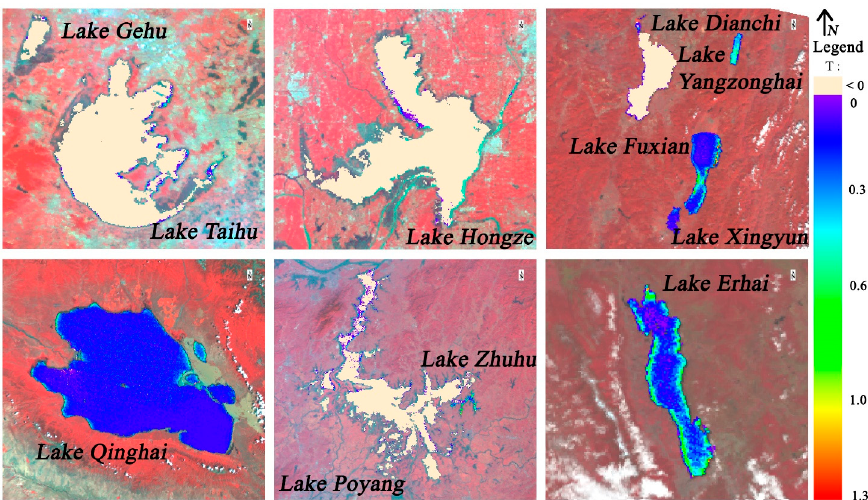
Figure 11. Six typical spectral curves from the different water bodies. ( a ) Lake Hongze_1 and Lake Hongze_2 represent the pixels near the shore and away from the shore, respectively. The spectral curves of Lake Erhai, Lake Taihu, Lake Qinghai, and Lake Zhuhu are located in the corresponding lakes. To eliminate differences in magnitude between different turbid conditions, all spectral curves were normalized based on R rs (2250) with their distributions displayed in the histogram ( b ).